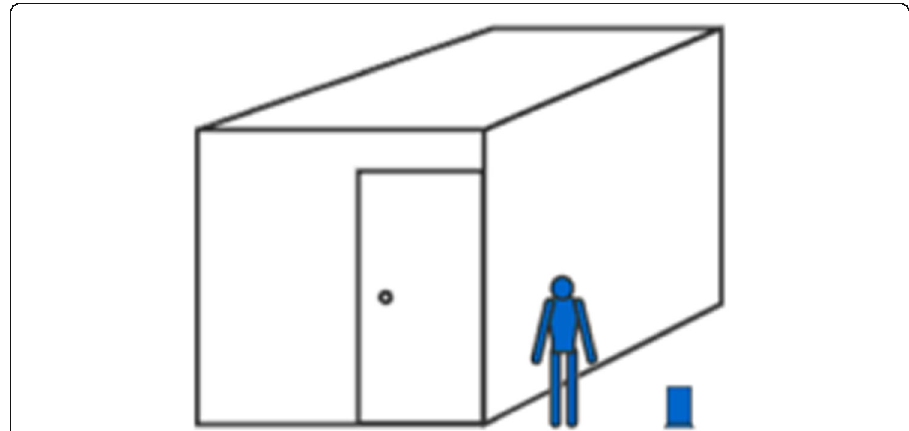
Fig. 1 Figurative illustration comparing Fanuc ’ s NC system to the US system. A size of a small room is reduced to a mounting on the